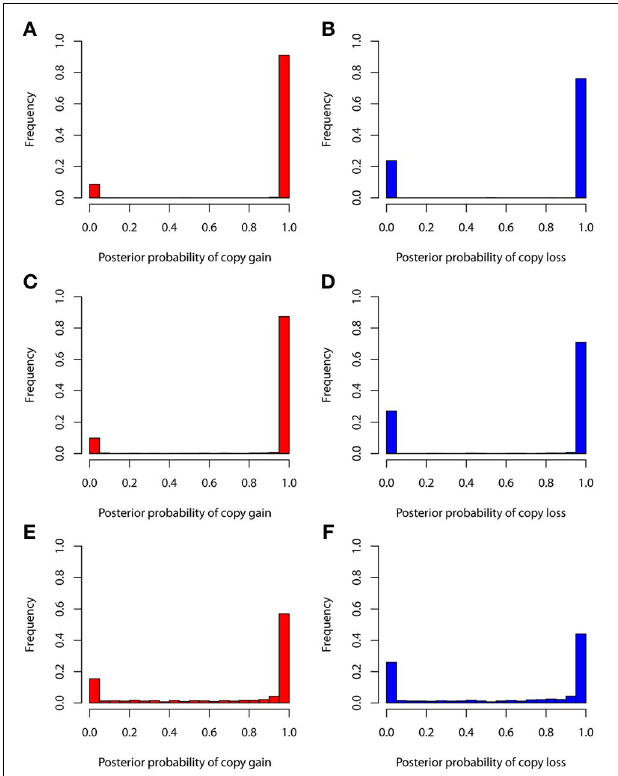
FIGURE 5 | False positive rates of detecting copy gain and copy loss under various standard deviations. (A) For copy gain when SD = 0 . 15, (B) for copy loss when SD = 0 . 15, (C) for copy gain when SD = 0 . 20, (D) for copy loss when SD = 0 . 20, (E) for copy gain when SD = 0 . 25, and (F) for copy loss when SD = 0 . 25.